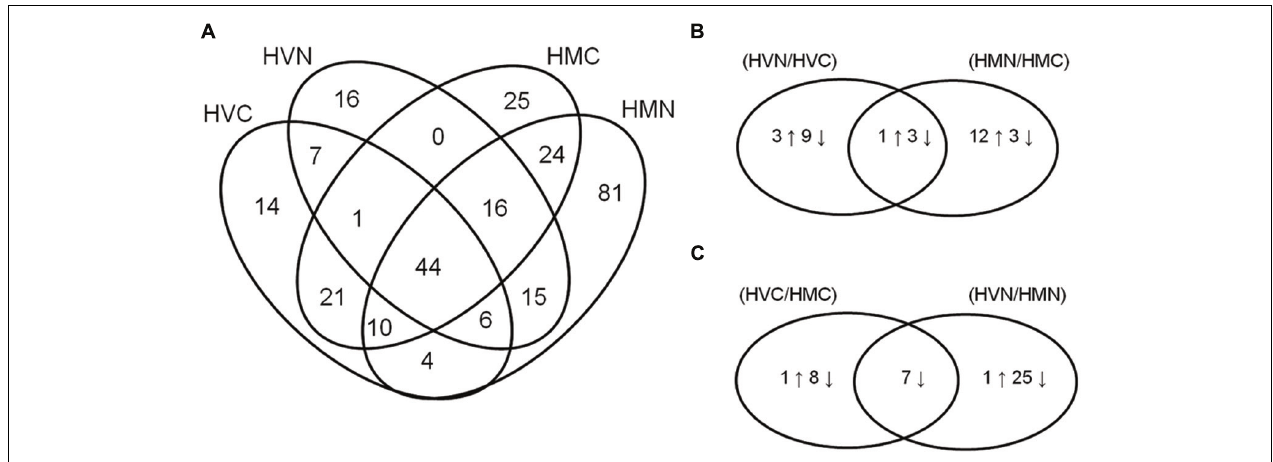
FIGURE 3 | Venn diagrams showing the number of identified proteins in all experimental variants studied (A; HVC, Hordeum vulgare , control treatment; HVN, H. vulgare , 300 mM NaCl; HMC, H. marinum , control treatment; HMN, H. marinum , 300 mM NaCl) and Venn diagrams showing identified proteins revealing significant differences in their relative protein abundance between control and salt-treated plants (B) and between H. vulgare and H. marinum genotypes (C). (B,C) the number of proteins showing significant differences between the experimental variants is indicated. Differences were evaluated by unpaired Student’s t -test at 0.05